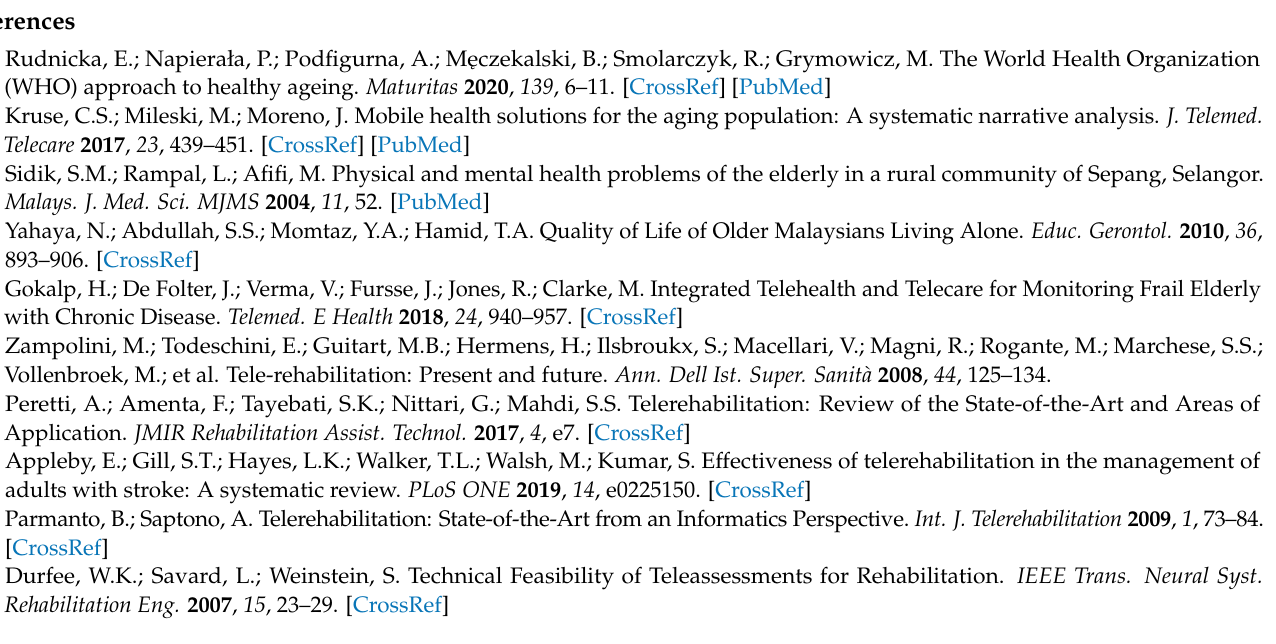
Figure A1. Preferred Reporting Items for Systematic Reviews and Meta-Analyses Extension for Scoping Review (PRISMA-ScR) flow diagram for telerehabilitation among older adults with mild cognitive impairment and cognitive